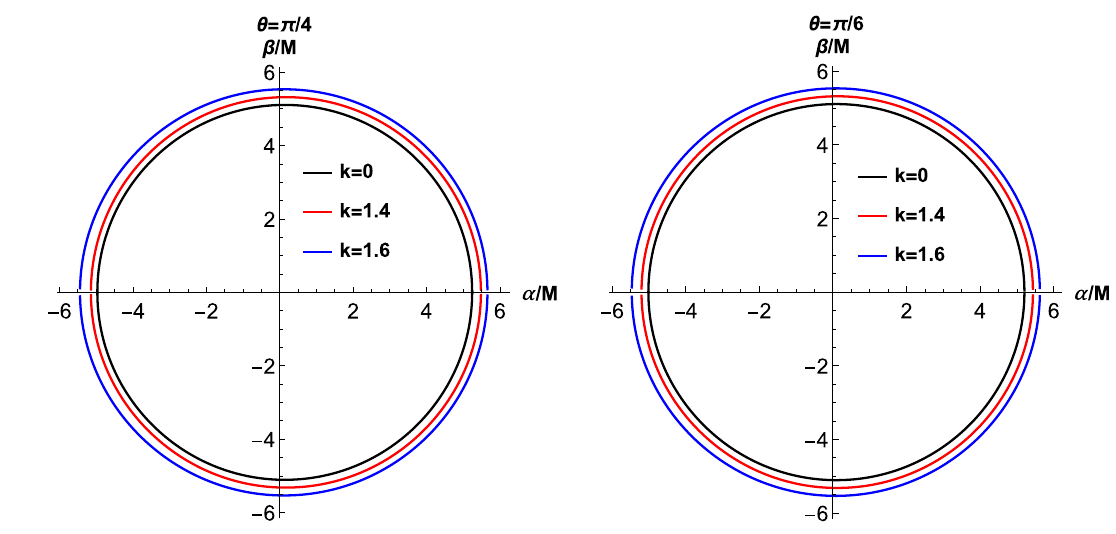
and θ = π with a = 0 . 1 , b = 0 . 1, and l = − 0 . 1 2 3